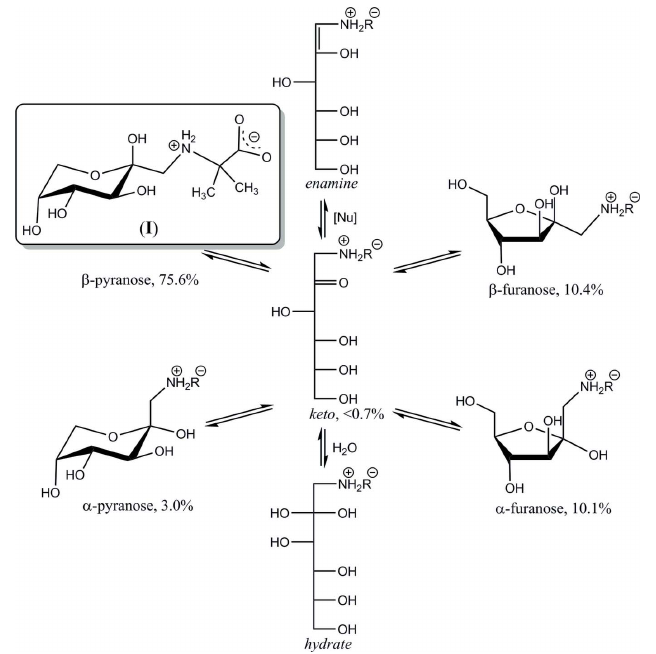
Figure 1 Equilibrium in aqueous solution of (I), at 293 K and pH 6.